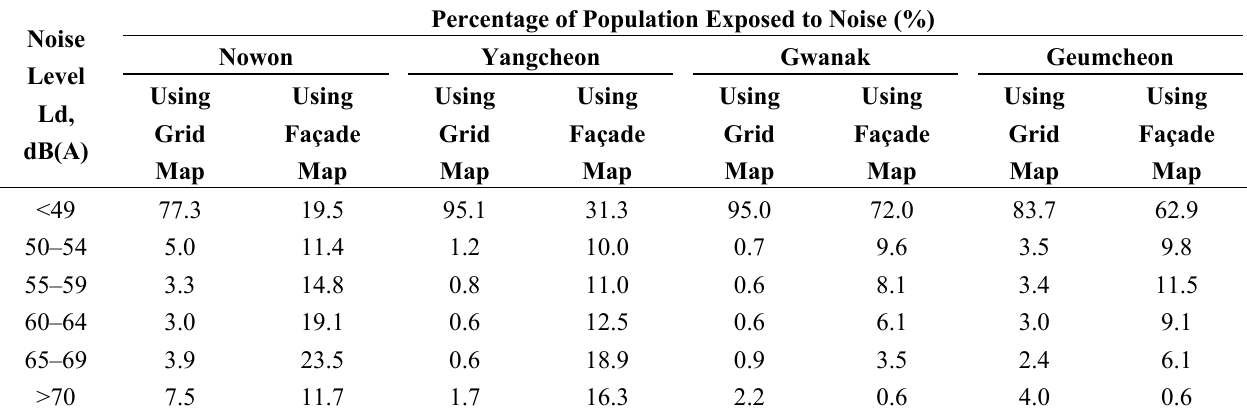
Table 2. Percentage of exposed population by noise levels using two different